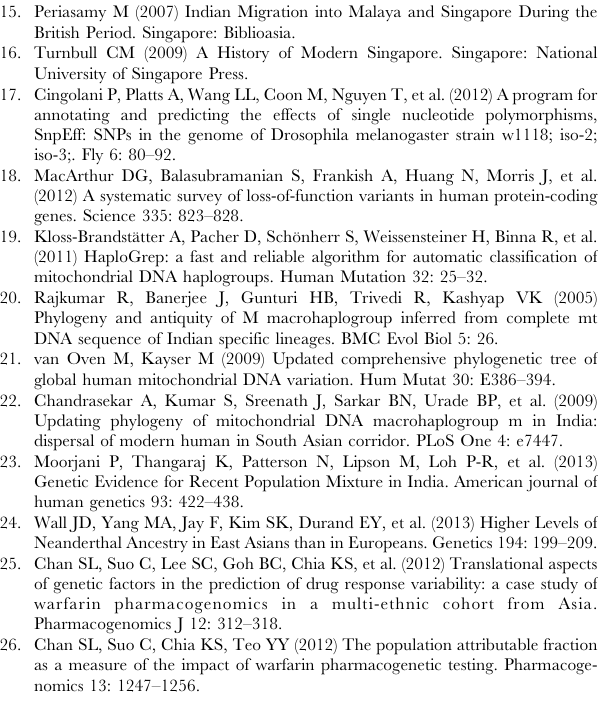
Table S4 Summary of single sample Loss-of-function (LOF) variants. Table S5 List of pathways affected by Loss-of-function (LOF) variants. Table S6 List of Loss-of-function (LOF) variants found in COSMIC database. Table S7 List of Loss-of-function (LOF) variants related to GWAS studies. Table S8 The proportions for 6 ancestral populations extracted from the output of ADMIXTURE program. Table S9 D statistic analysis with ancient genome for 5 randomly selected pairwise samples, anchored with different SSIP ancient